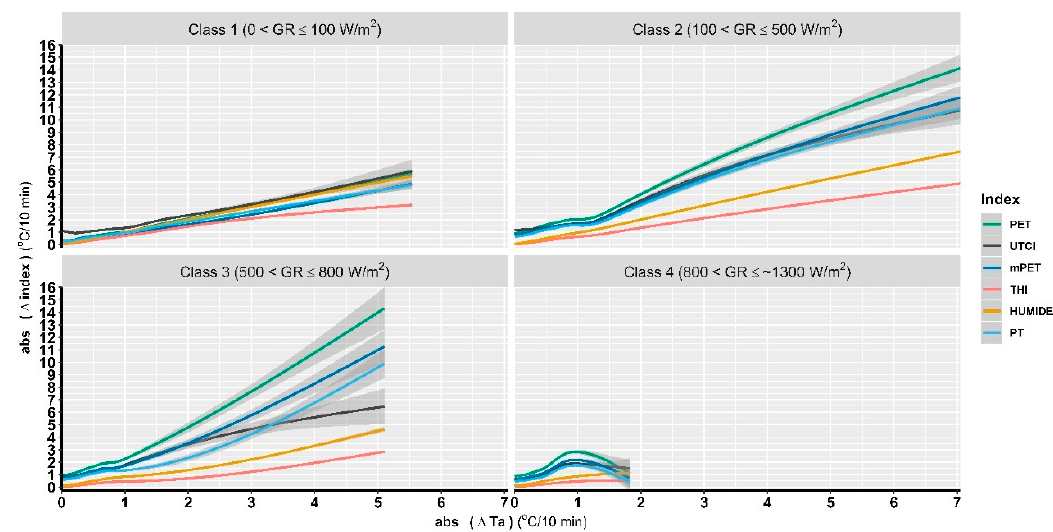
Figure 10. The sensitivity of the indices to the air temperature (T a ) change rate under different global radiation (GR) conditions.